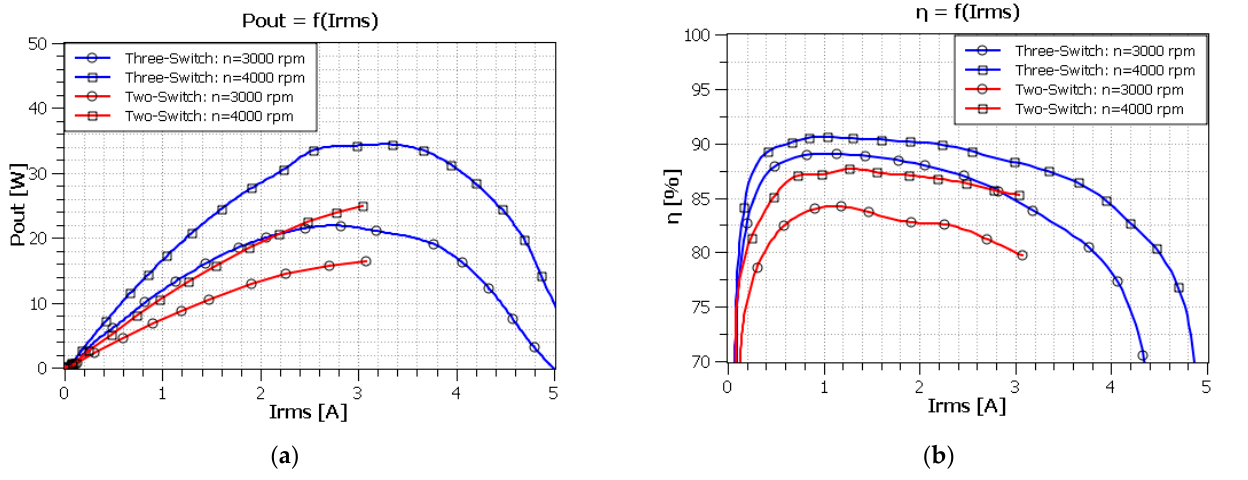
Figure 12. The output power of the converter ( a ) and efficiency ( b ) for two rotational speeds of 3000 and 4000 rpm as a function of the rms phase current.